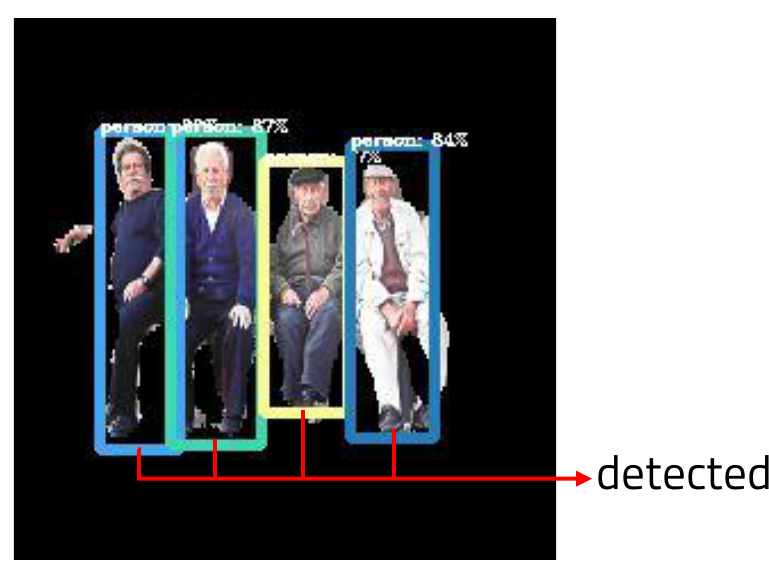
Figure 11. Results of YOLO object